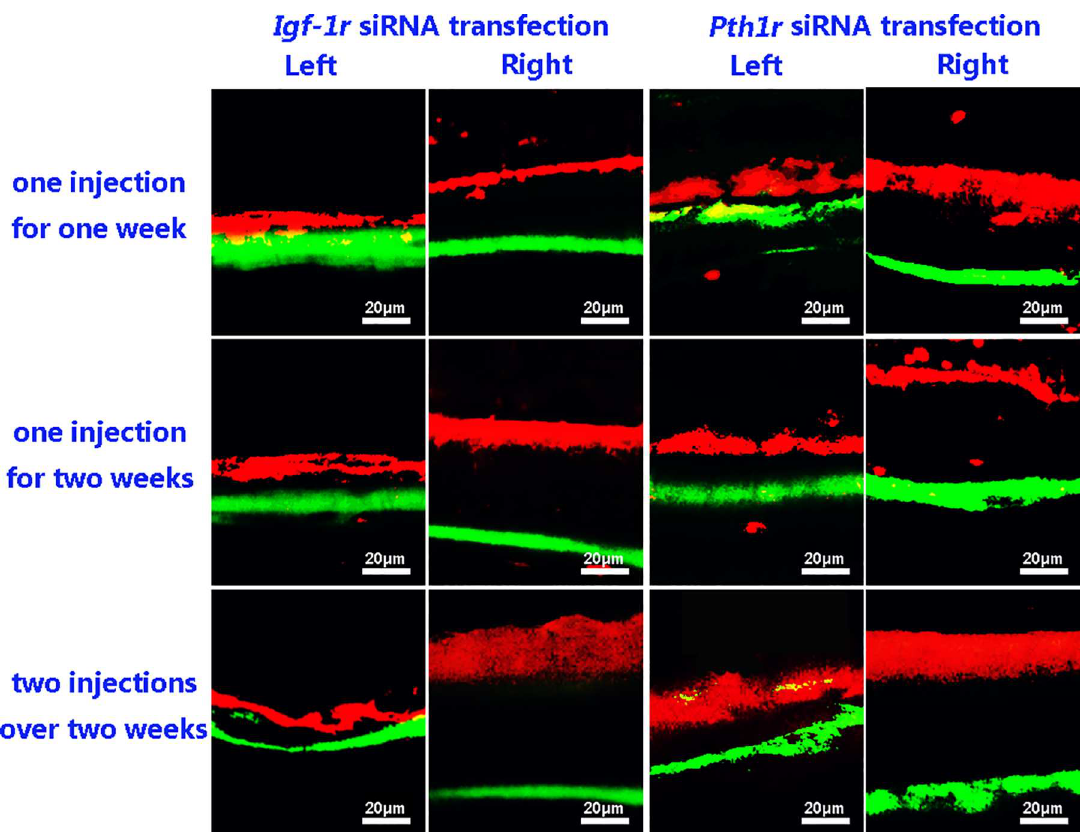
Fig 7. Representative Images of Double Fluorochrome Labeling. In the Igf-1r siRNA transfectiongroup, the distance betweenthe two labels in the left tibias treated with Igf-1r siRNA and IGF-1 was significantly shorter than that in the right tibias treated with IGF-1 only. In the Pth1r siRNA transfectiongroup, this distancewas also markedly decreased in the left tibias treated with Pth1r siRNA and rhPTH (1–34) comparedto the right tibias treated with rhPTH (1–34) only. Scale bar = 20 μ